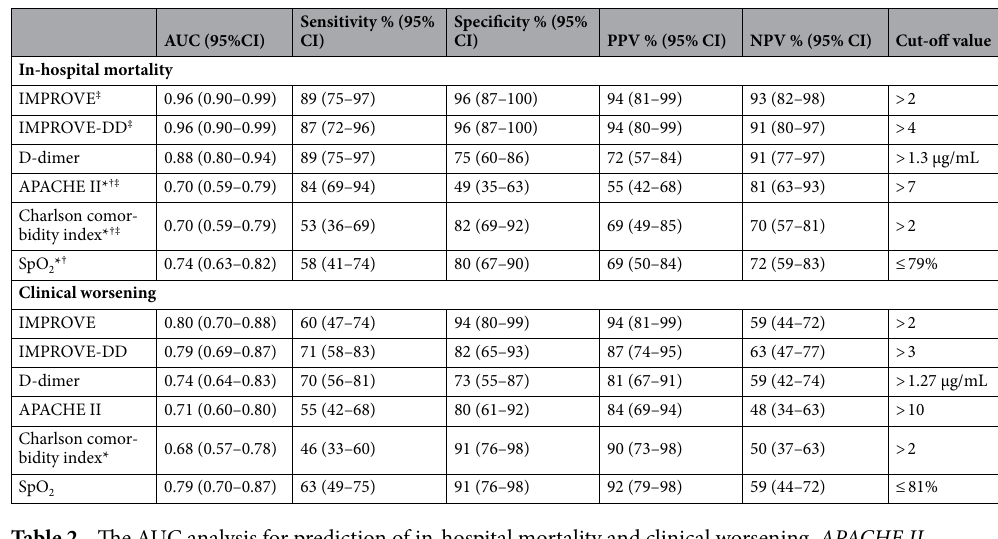
Table 2. The AUC analysis for prediction of in-hospital mortality and clinical worsening. APACHE II acute physiology and chronic health evaluation II, AUC area under receiver operating characteristic curve, CI confidence interval, DD D-dimer, IMPROVE international medical prevention registry on venous thromboembolism, NPV negative predictive value, PPV positive predictive value, SpO 2 peripheral oxygen saturation. *Denotes significance in relation to the IMPROVE. † Denotes significance in relation to the IMPROVE-DD. ‡ Denotes significance in relation to the D-dimer.